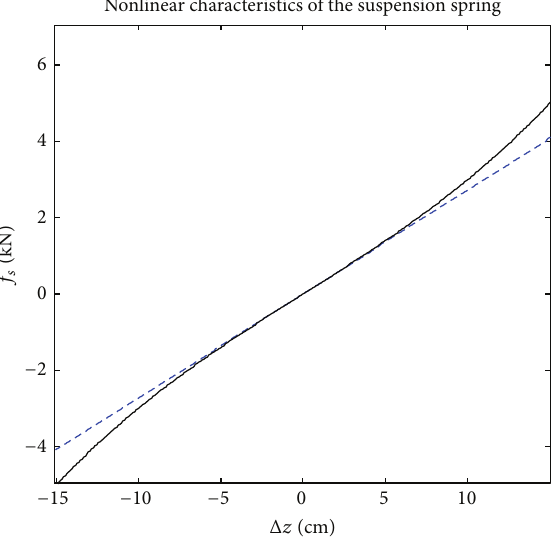
Figure 2: Force-displacement curve of nonlinear